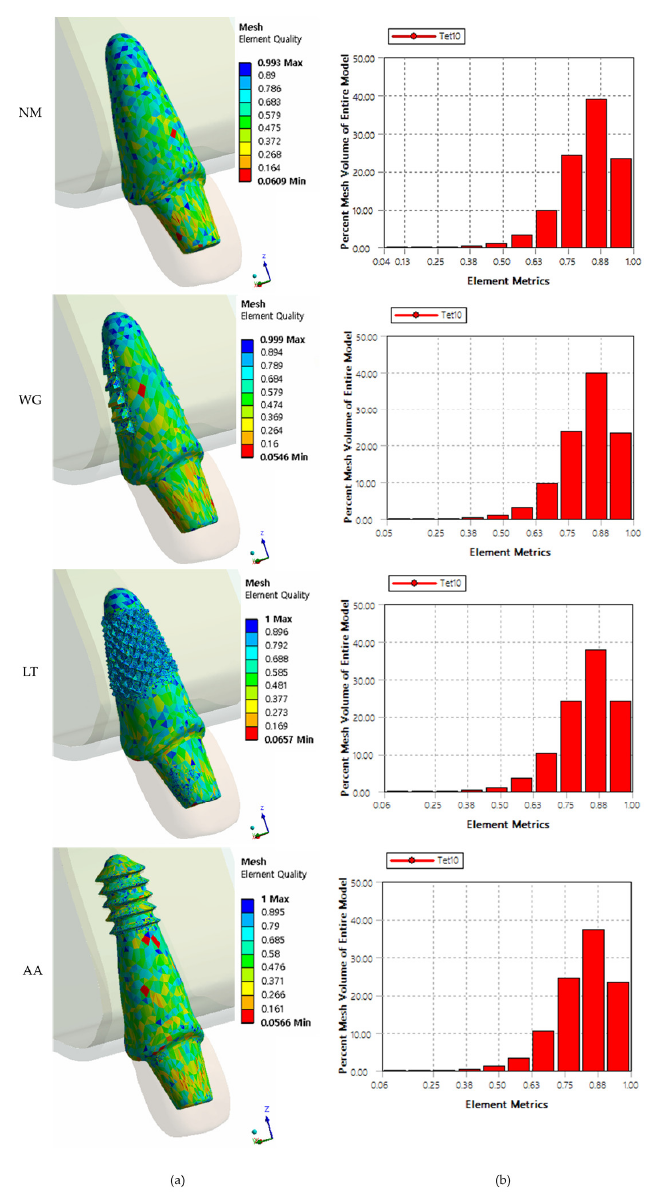
Figure 6. Quality of elements in RAIs ( a ) and statistics ( b ) of each experimental group.